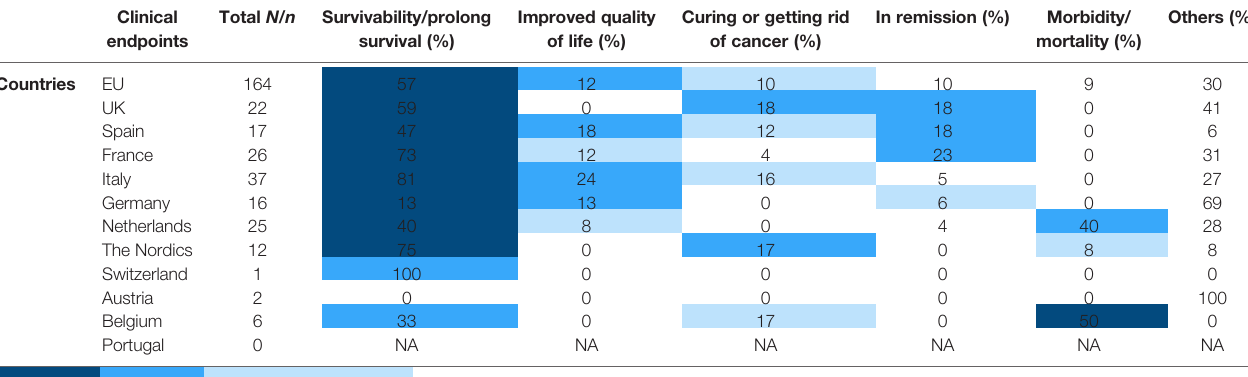
TABLE 6 | Clinical endpoints